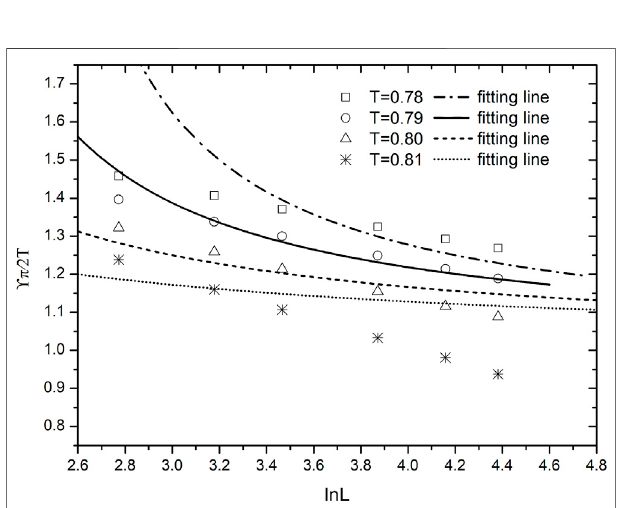
FIGURE 3 | Application of the fi nite-size scaling of  ( T ) to estimate the critical temperature for q (cid:1) 10. The lines are fi ts to the fi nite-size scaling relation of Eq. 4 .